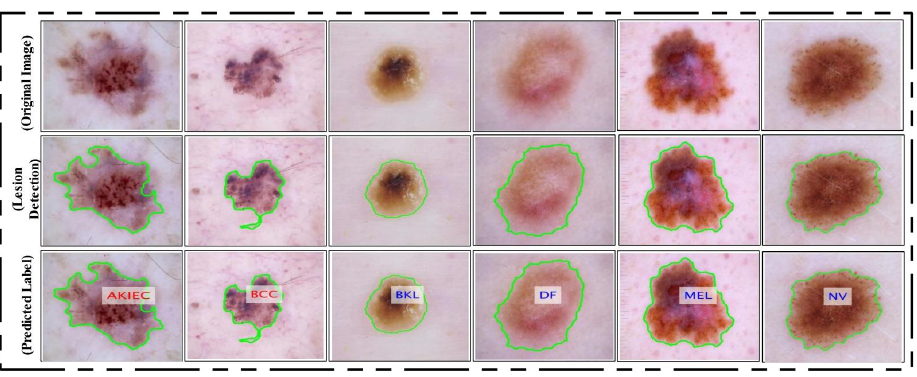
Figure 15. Proposed lesion localization and labeled results. Lesions are labelled as actinic keratosis/Bowen’s disease (intraepithelial carcinoma) (AKIEC), basal cell carcinoma (BCC), benign keratosis (solar lentigo/seborrheic keratosis/lichen planus-like keratosis) (BKL), dermatofibroma (DF), melanoma (MEL), and melanocytic nevus (NV).